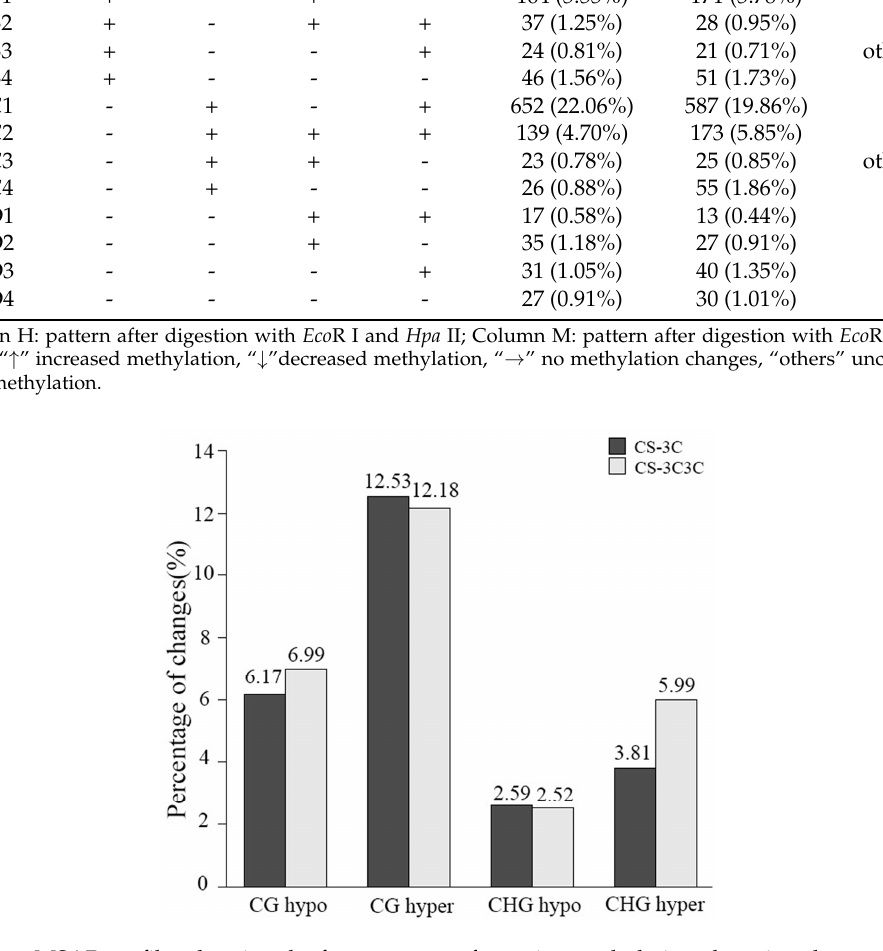
Figure 2. MSAP profiles showing the four patterns of cytosine methylation alterations between the CS–Gc addition lines and common wheat CS.